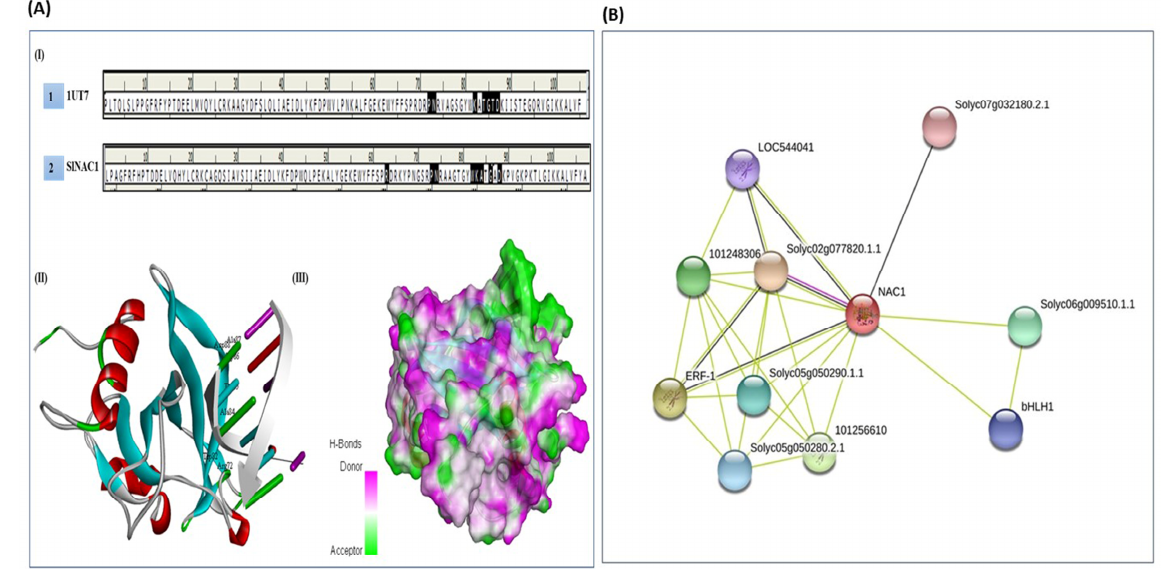
Figure 5. ( A ) ( I ) Docking analysis of SlNAC1 and 1UT7 with DNA motif. PNWKATGTD and RPNWKATGAD of SlNAC1 and 1UT7 interacted with DNA motif. ( II ) Docked SlNAC1 with DNA motif. ( III ) Three-dimensional surface view for docked complex in terms of hydrogen bonds donor and acceptor groups. ( B ) Protein–protein interaction network of SlNAC1 with other protein family members.